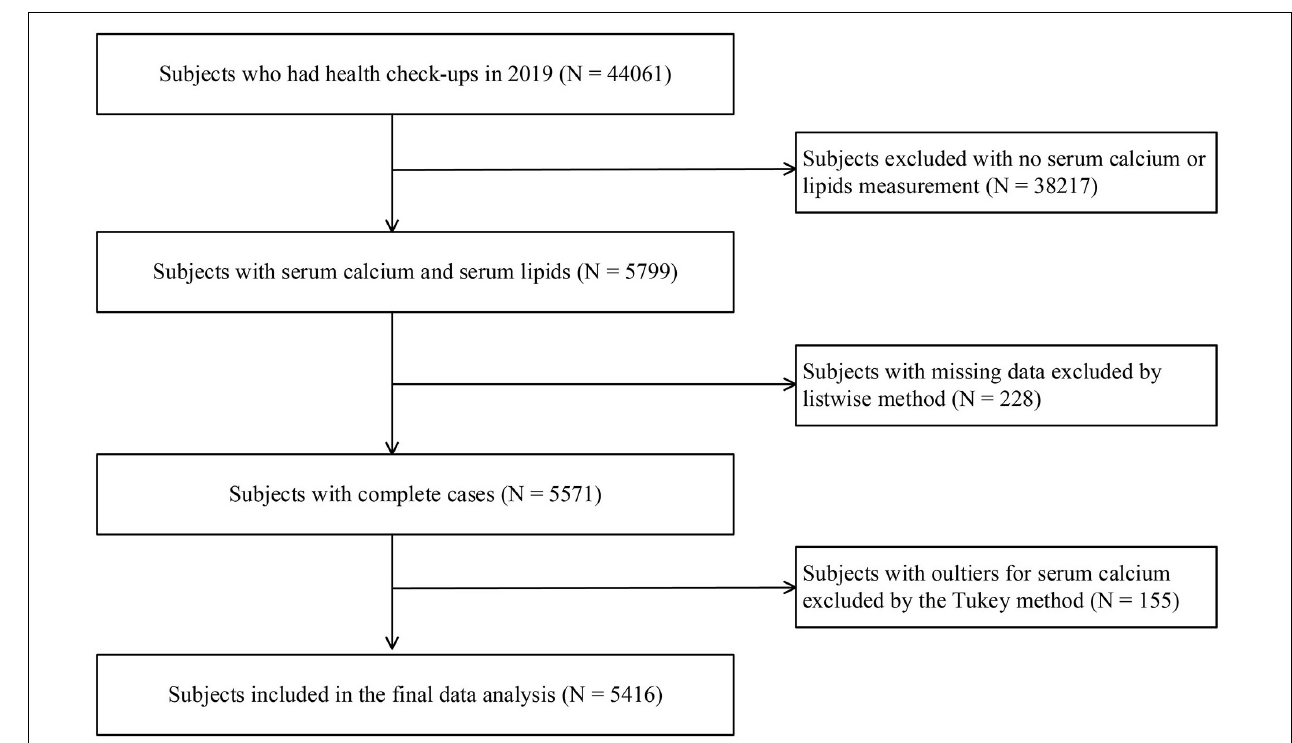
FIGURE 1 | Flow chart of the subject selection